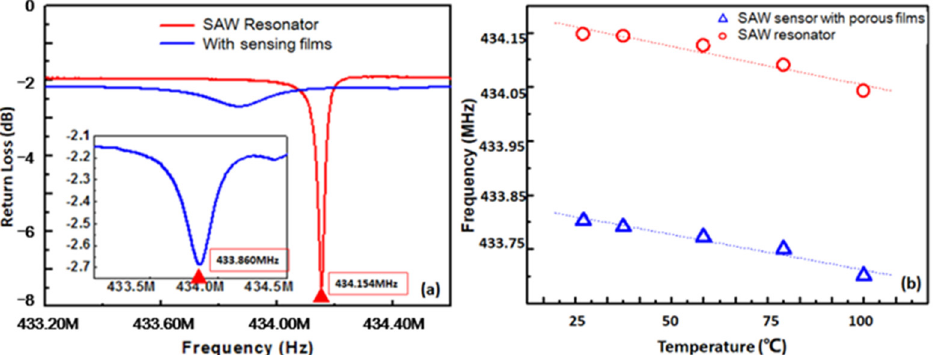
Figure 7. ( a ) Frequency characteristics of the SAW resonators (red) and SAW sensors with sensing films (blue), ( b ) TCF of the SAW resonators (red) and SAW sensors with sensing films (blue).